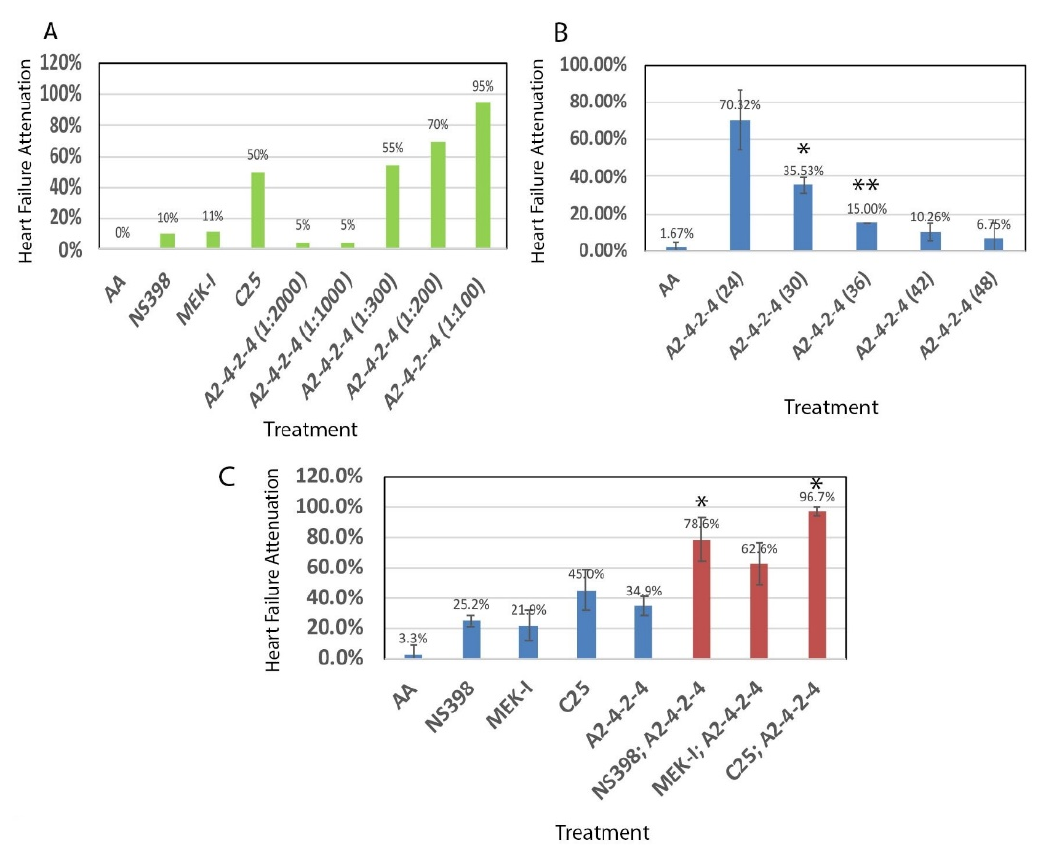
Figure 4. A2-4-2-4 pharmacodynamics. ( A ) A2-4-2-4 showed the heart failure attenuation activity in a dosage-dependent manner. ( B ) Time course experiments showed that A2-4-2-4 is required at the early phase of AA-induced AHF. Embryos were treated with AA from 24–72 hpf and A2-4-2-4 added at different times, 24, 30, 36, 42, or 48 hpf. The attenuation of A2-4-2-4 was about 70% when added at 24 hpf but dropped to 35% when added six hours later at 30 hpf (* indicates statistical significance by t -test, p = 0.038; ** between A2-4-2-4 (36) and A2-4-2-4 (30), p = 0.014). A2-4-2-4 lost 90% of the attenuation efficacy when added 24 h later (70% at 24 hpf vs. 7% at 48 hpf). ( C ) A combinational experiment with sub-dosage of the compounds identified in our lab, 10 µ M of NS398, 1:500 dilutions of A2-4-2-4, 5 µ M of MEK-I, 2 µ M of C25, showed a possible synergistic effect between A2-4-2-4 and NS398, comparing the attenuation of double treatment by NS398; A2-4-2-4 (78.6%) with that of lone NS398 (25.2%) or A2-4-2-4 (34.9%) treatment. (* indicates the statistical significance by t -test, p < 0.05). Similarly, the data suggest a possible synergistic effect between A2-4-2-4 and C25 (* indicates statistical significance by t -test, p < 0.05 between the double versus single treatments) but an additive effect between A2-4-2-4 and